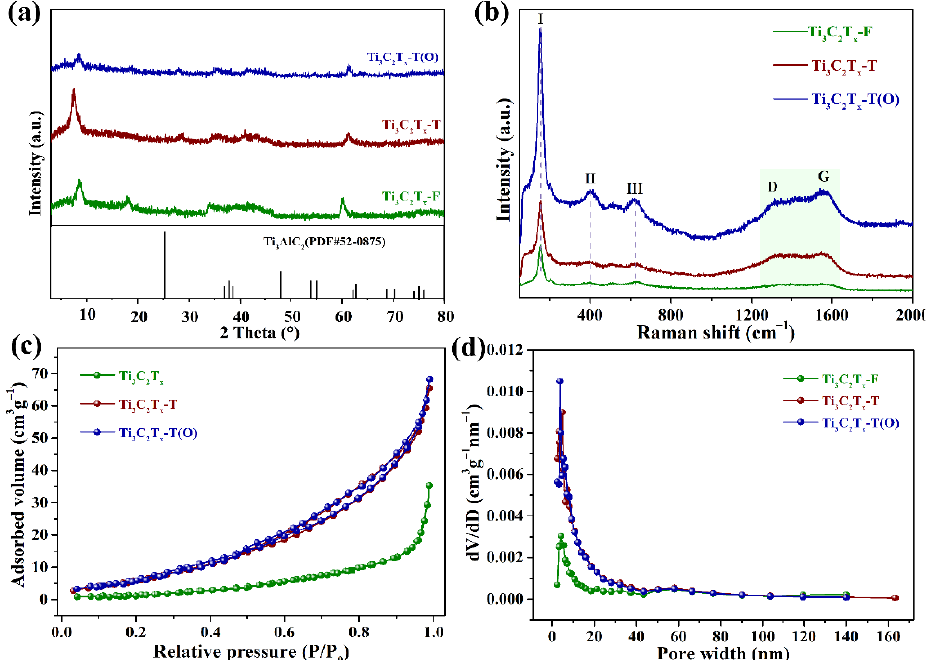
Figure 3. ( a ) XRD patterns; ( b ) Raman spectra; ( c ) N 2 adsorption/desorption isotherms; ( d ) the pore- size distribution of Ti 3 C 2 T x -F, Ti 3 C 2 T x -T and Ti 3 C 2 T x -T(O).